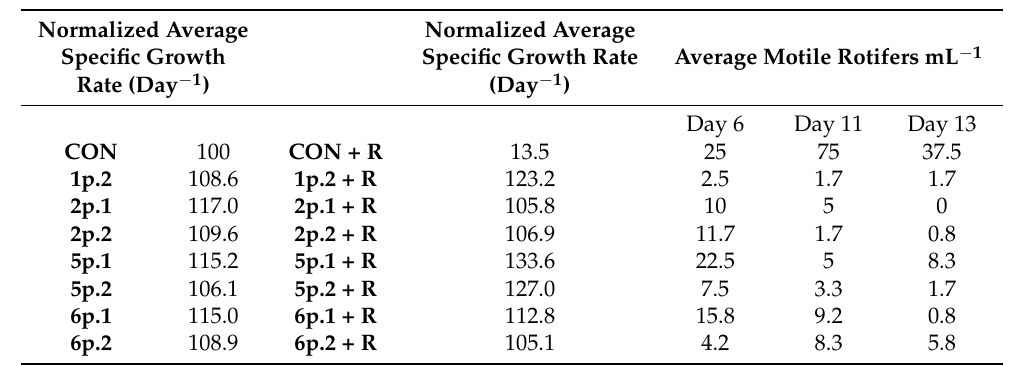
Table 1. Normalized average specific growth rate (day − 1 ) of untreated M. salina (CON) or M. salina treated with bacterial communities (1p.2, 2p.1, 2p.2, 5p.1, 5p.2, 6p.1, 6p.2; described further in Section 2.1) and average motile rotifers (mL − 1 ) present in cultures treated with rotifers (+R).